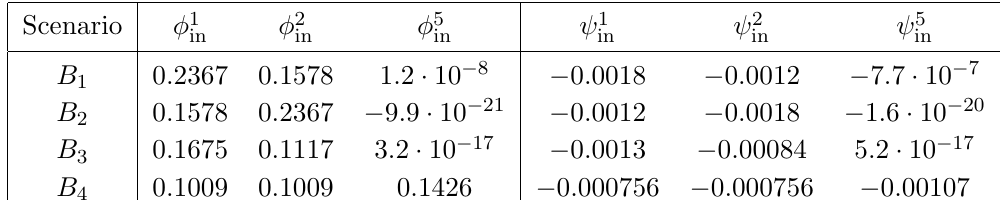
Table 3. Initial conditions ((cid:12)elds in units of M Pl ) at N (cid:3) table 1).